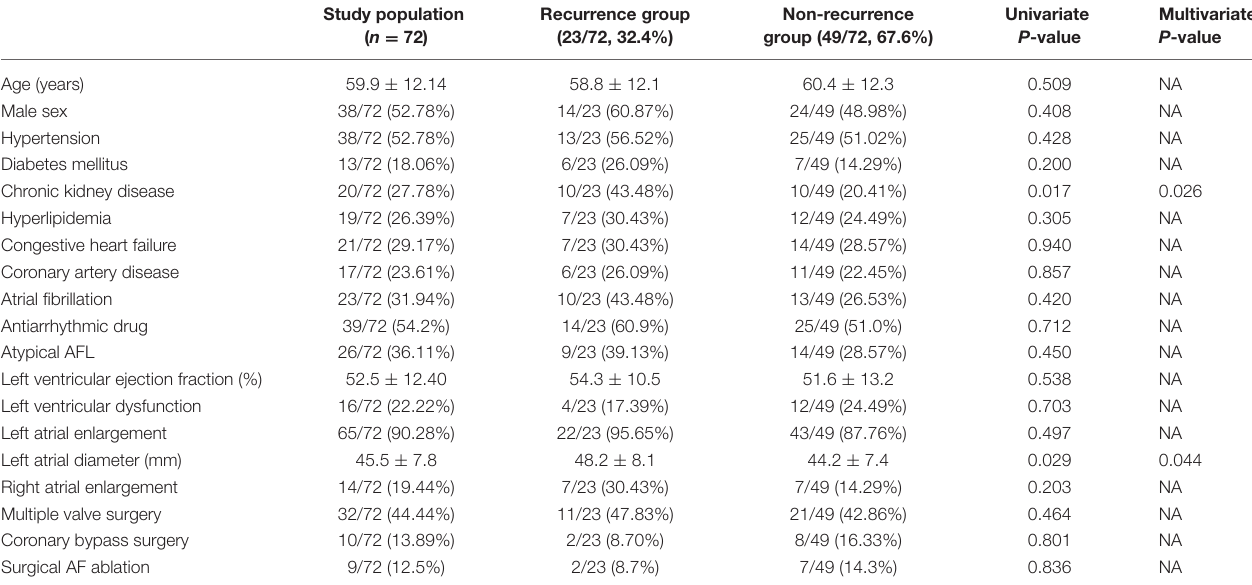
TABLE 6 | Univariate and multivariate Cox regression analyses for each risk factor of recurrent atrial tachyarrhythmia.